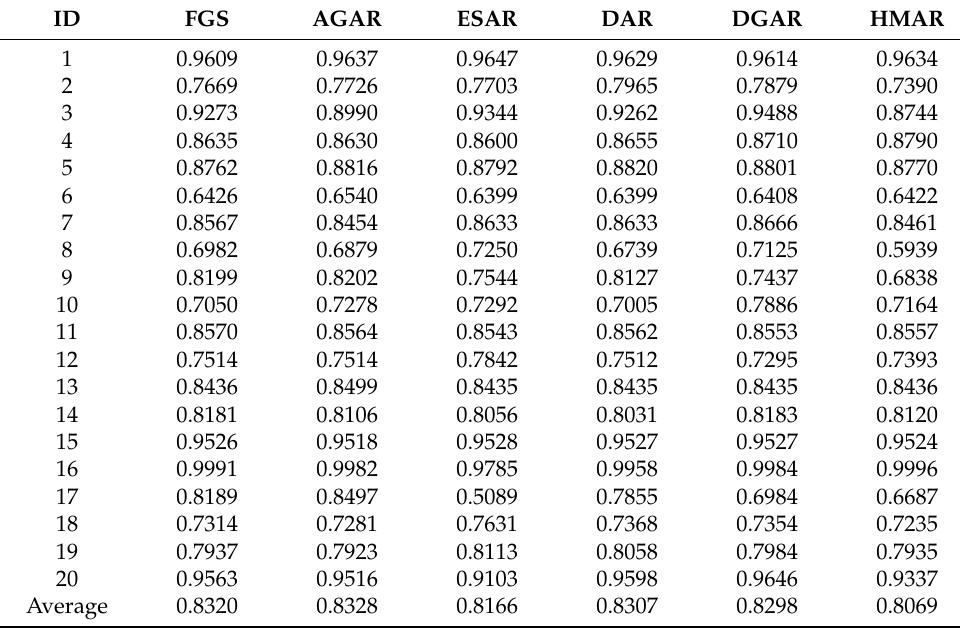
Table 7. Classification accuracies based on KNN classifier ( k =